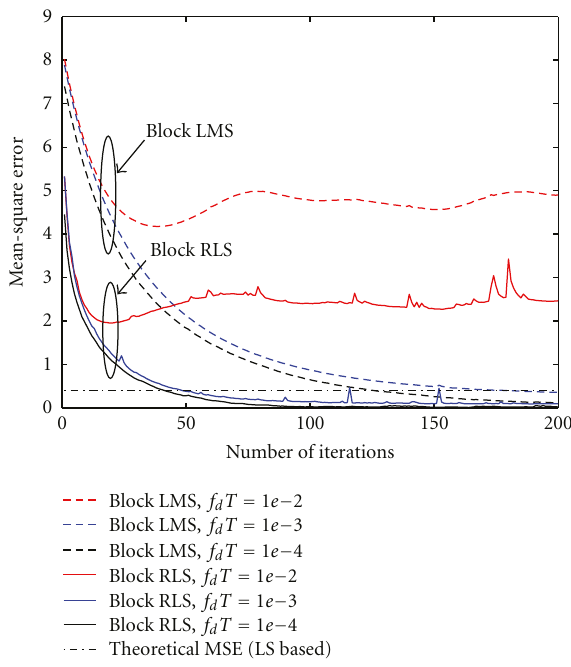
Figure 8: Learning curves of the block-wise LMS and RLS algo- rithms for E {(cid:10) v F ( k ) (cid:10) 2 } under di ff erent Doppler spreads: f d T = 10 − 4 , 10 − 3 , and 10 − 2 . Block RLS: λ = 0 . 8; block LMS: μ = 0 .